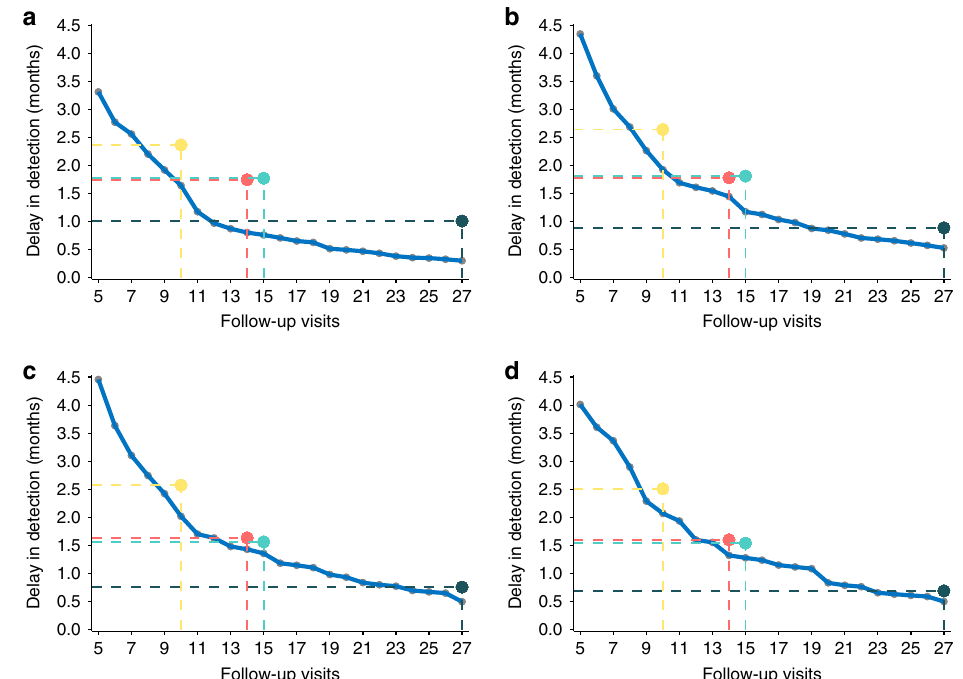
Fig. 4 Comparisons of delays in the detection of disease failure in different surveillance strategies for each staging group. Delays in the detection of disease failure in risk-based surveillance arrangements (blue curve) compared with the control follow-up strategies (the yellow, green, and blue horizontal lines, respectively, represent the most intensive, moderately intensive and least intensive surveillance strategies according to NCCN; the brown horizontal line represents the RTOG strategy) for patients in group I ( a ), group II ( b ), group III ( c ), and group IV ( d ). Note that the delays in detection was calculated using a hypothetical cohort of 1000 nasopharyngeal carcinoma patients with the same features with our study